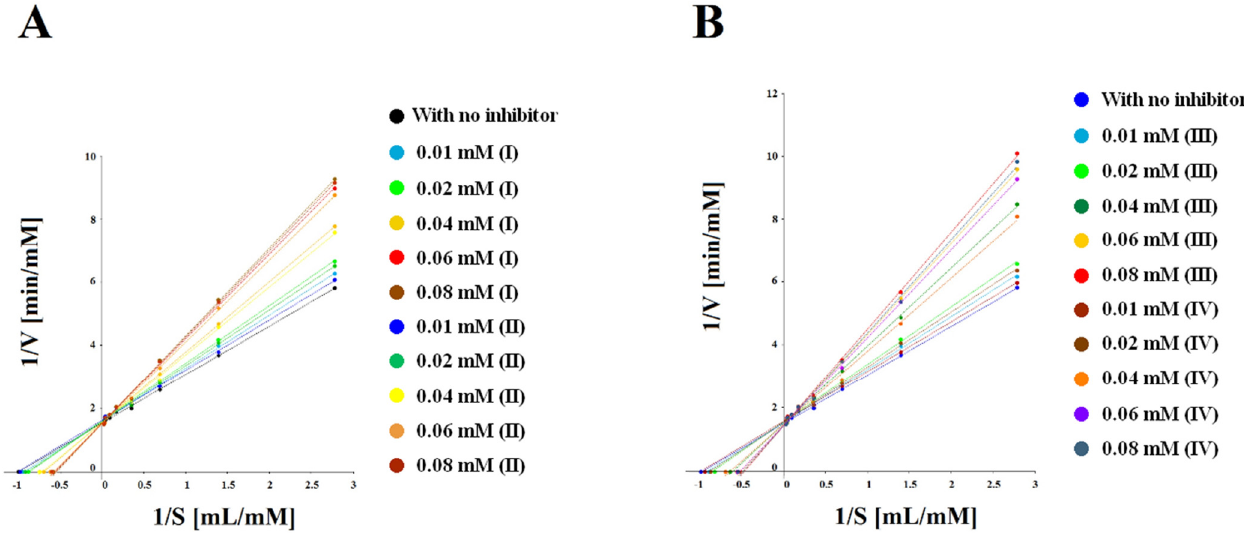
Figure 4. Lineweaver–Burk plots for systems with inhibitors (I) and (II) ( A ) and (III) and (IV) ( B ) at concentrations of 0.01, 0.02, 0.04, 0.06 and 0.08 mM.